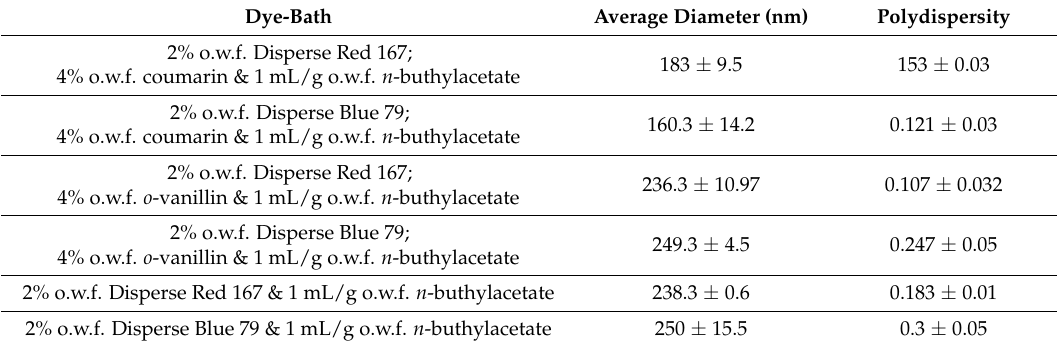
Table 2. Particle size of dyebath in a presence of Coumarin, vanillin and without